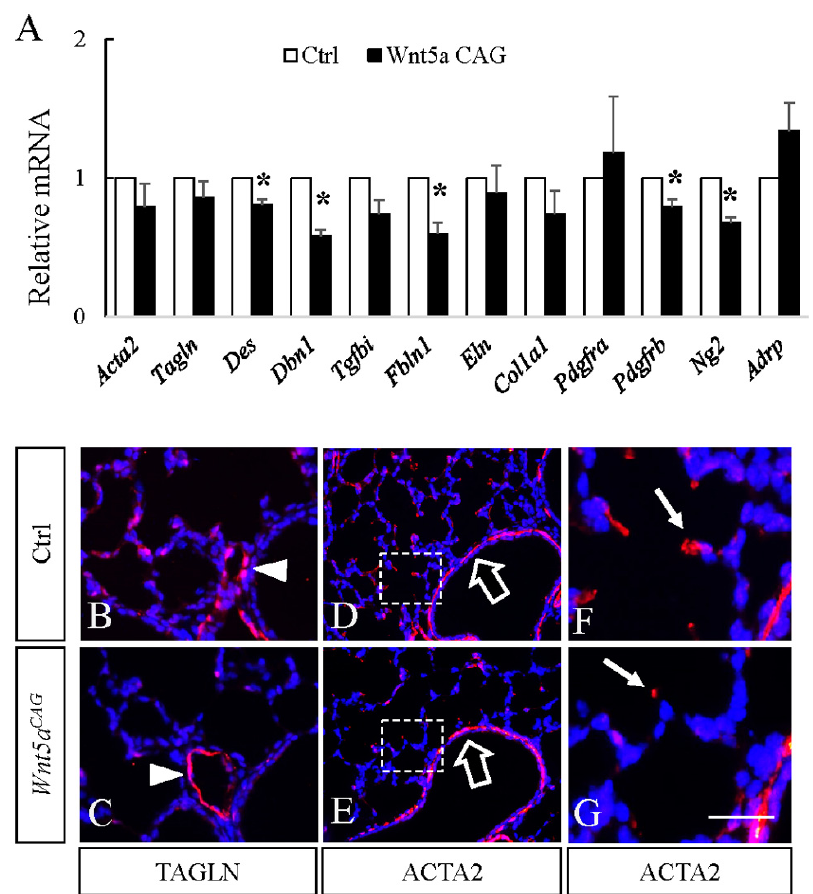
Figure 5. Postnatal inactivation of Wnt5a decreases expression of genes enriched in myofibroblasts. A : Relative mRNA for genes enriched in myofibroblasts in Wnt5a CAG lungs (Wnt5a CAG, P12-13) compared to the littermate control lungs by real-time RT-PCR analysis. Data represent the mean ± SEM. * indicates p < 0.05. n = 4. B – G: Immunostaining of TAGLN ( B and C ) and ACTA2 ( D – G ) in P12 control ( B , D and F ) and Wnt5a CAG ( C , E and G ) lungs. Panels F and G show higher magnification views of boxed areas in D and E , respectively. Nuclei are counterstained with DAPI. Arrowheads in B and C indicate TAGLN-positive perivascular smooth muscle cells. Block arrows in D and E indicate ACTA2 positive parabronchial smooth muscle cells. Arrows in F and G indicate ACTA2 positive alveolar myofibroblast cells. Scale bars ( G ): 50 μ m for B and C , 100 μ m for D and E , 25 μ m for F and G .